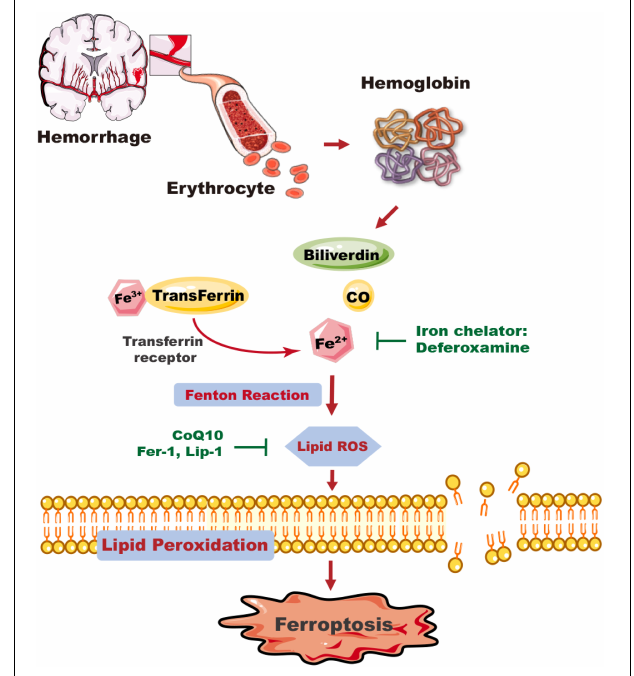
FIGURE 1 | The mechanism of ICH-induced ferroptosis in the brain. Following ICH, erythrocytes release hemoglobin, which produces a degradation product, carbon monoxide (CO), biliverdin, and free iron. Excess Fe 2 + , the reactive form of iron, can generate ROS and cause membrane lipid peroxidation, and trigger ferroptosis. Deferoxamine can reduce the level of iron ions and inhibit the production of ROS and the occurrence of ferroptosis. The ferroptosis inhibitors CoQ10, Fer-1, and Lip-1 inhibit lipid ROS activity and ferroptosis. CO, carbon monoxide; CoQ10, coenzyme Q10; Fer-1, ferrostatin-1; Lip-1,